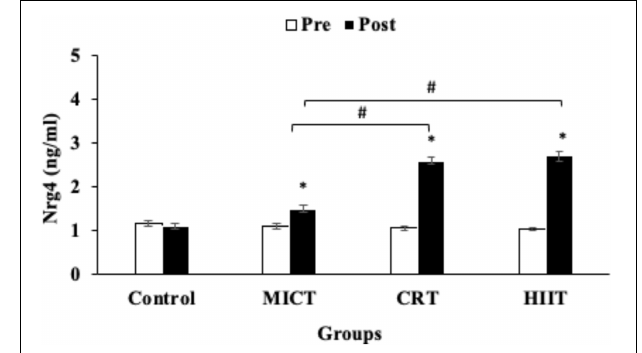
FIGURE 3 | Pre and post training values [mean, sd ( ± )] for HOMA-IR (Homeostatic Model Assessment-Insulin Resistance), in MICT (Moderate Intensity Continuous Training), CRT (Circuit Resistance Training), and HIIT (High Intensity Interval training) groups. *indicates significant differences from the control group ( P < 0.05). # indicates significant differences between training groups ( p < 0.05).